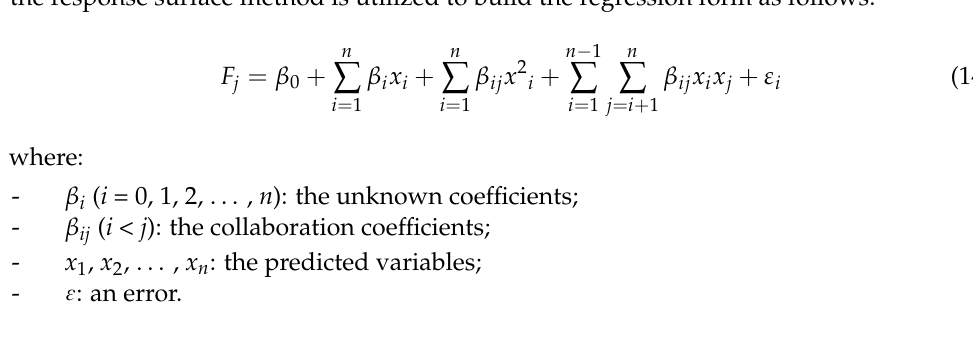
Figure 12. Flowchart of the combined optimization